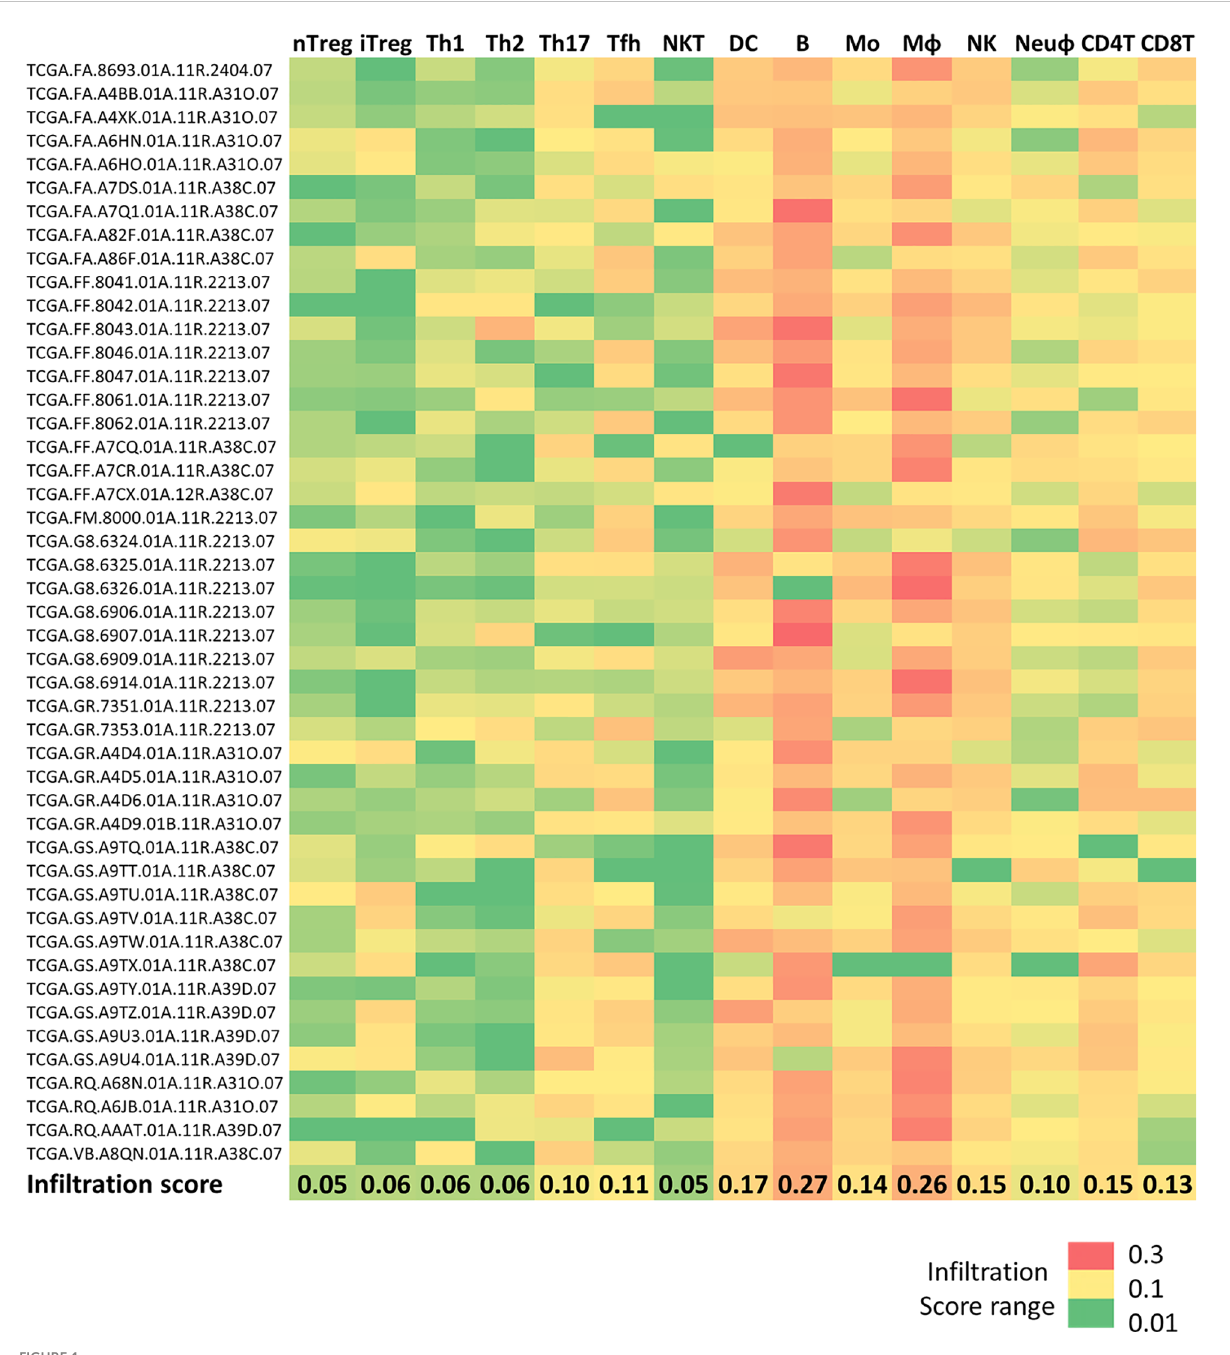
FIGURE 1 Immune cell in fi ltration in DLBCL and spleen samples Heatmap showing the in fi ltration scores of the indicated immune cell subtypes in 48 DLBCL samples from the TCGA expression database. The last line shows the mean in fi ltration score for each cell type. Green to red color: low to high in fi ltration score. Raw data were extracted from the ImmuCellAI database, analyzed, and converted into the heatmap. nTreg, natural regulatory T cells; iTreg, induced regulatory T cells; Th1, T helper 1 cells; Th2, T helper 2 cells; Th17, T helper 17 cells; Tfh, T follicular helper cells; NKT, natural killer T cells; DC, dendritic cells; B, B cells; MO, monocytes; M Ф , macrophages; NK, natural killer cells; Neu j , neutrophils; CD4T, CD4 T cells; CD8T, CD8 T